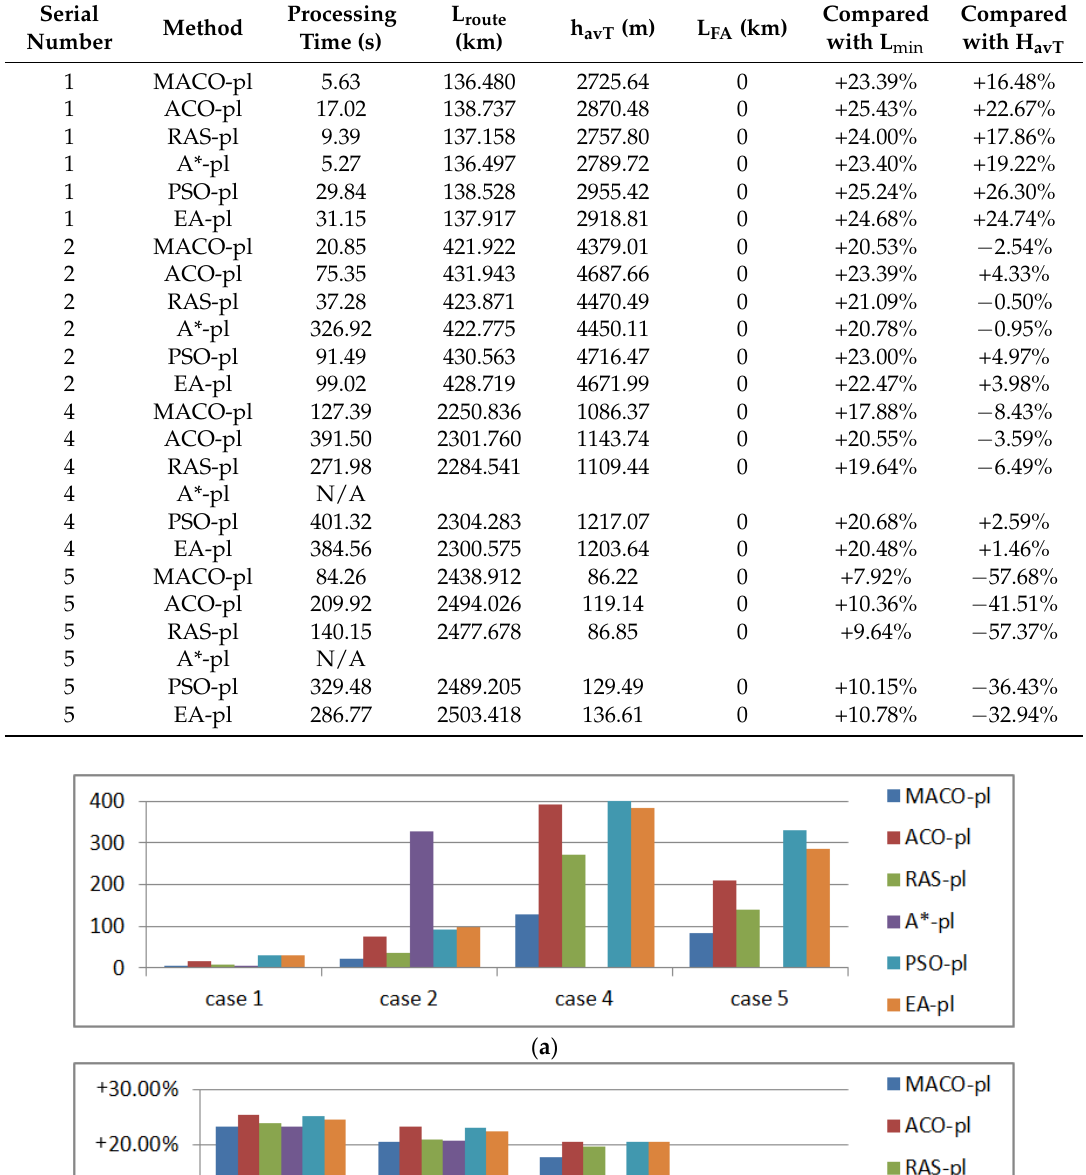
Table 7. Planning results in threat environments.